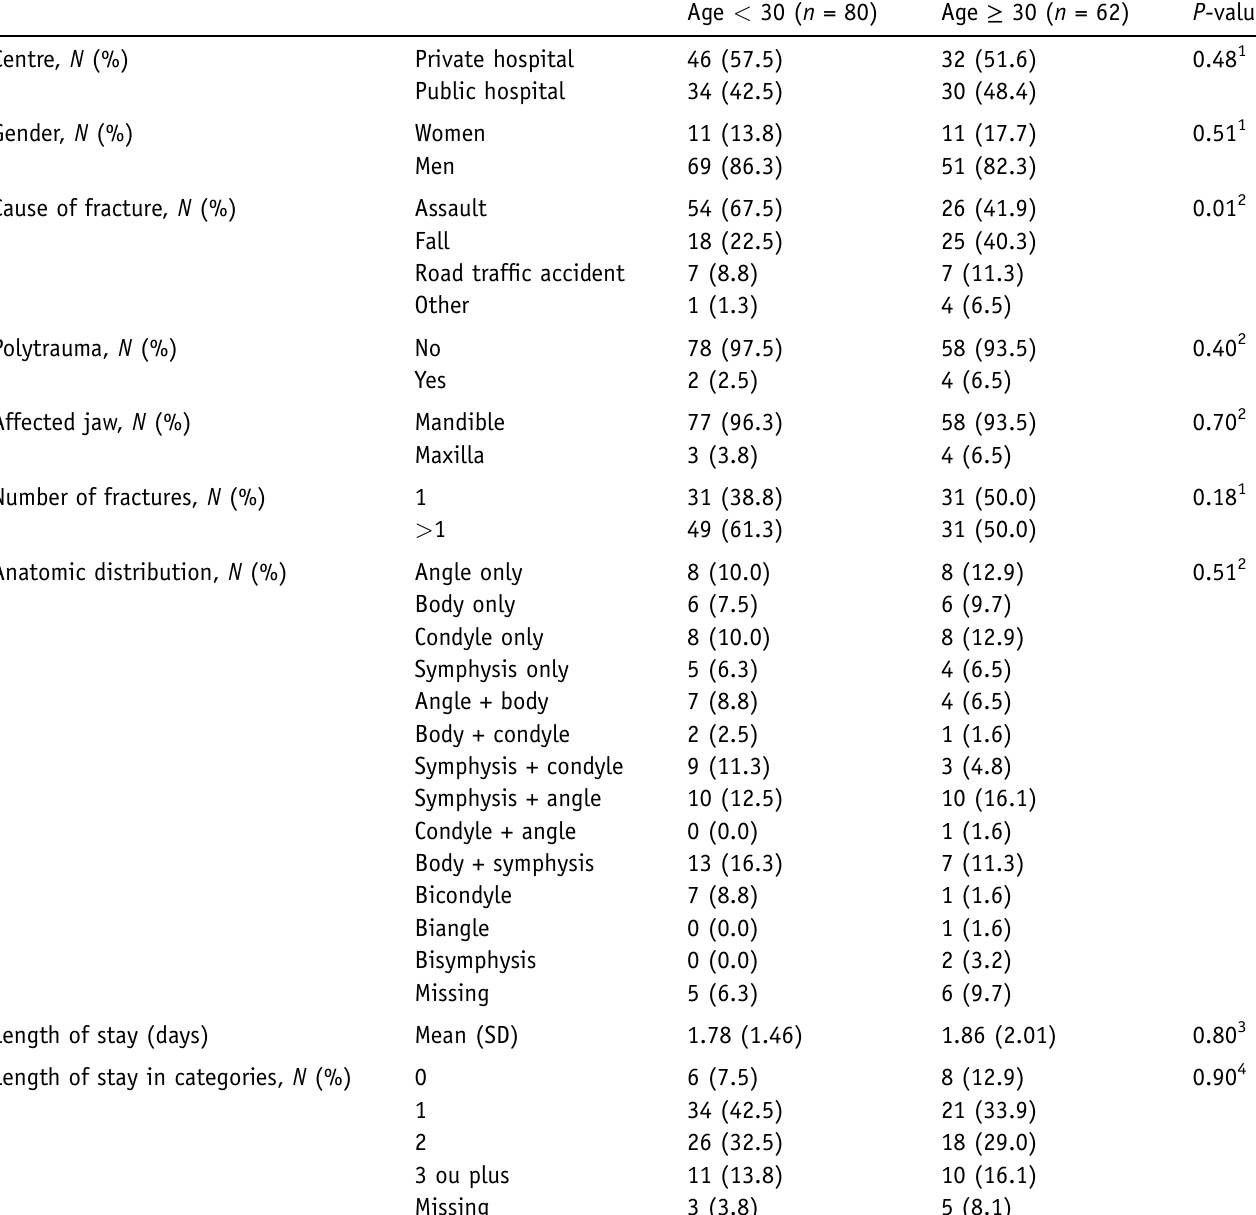
Table IV. Description of patients ’ characteristics and of jaw fractures according to age